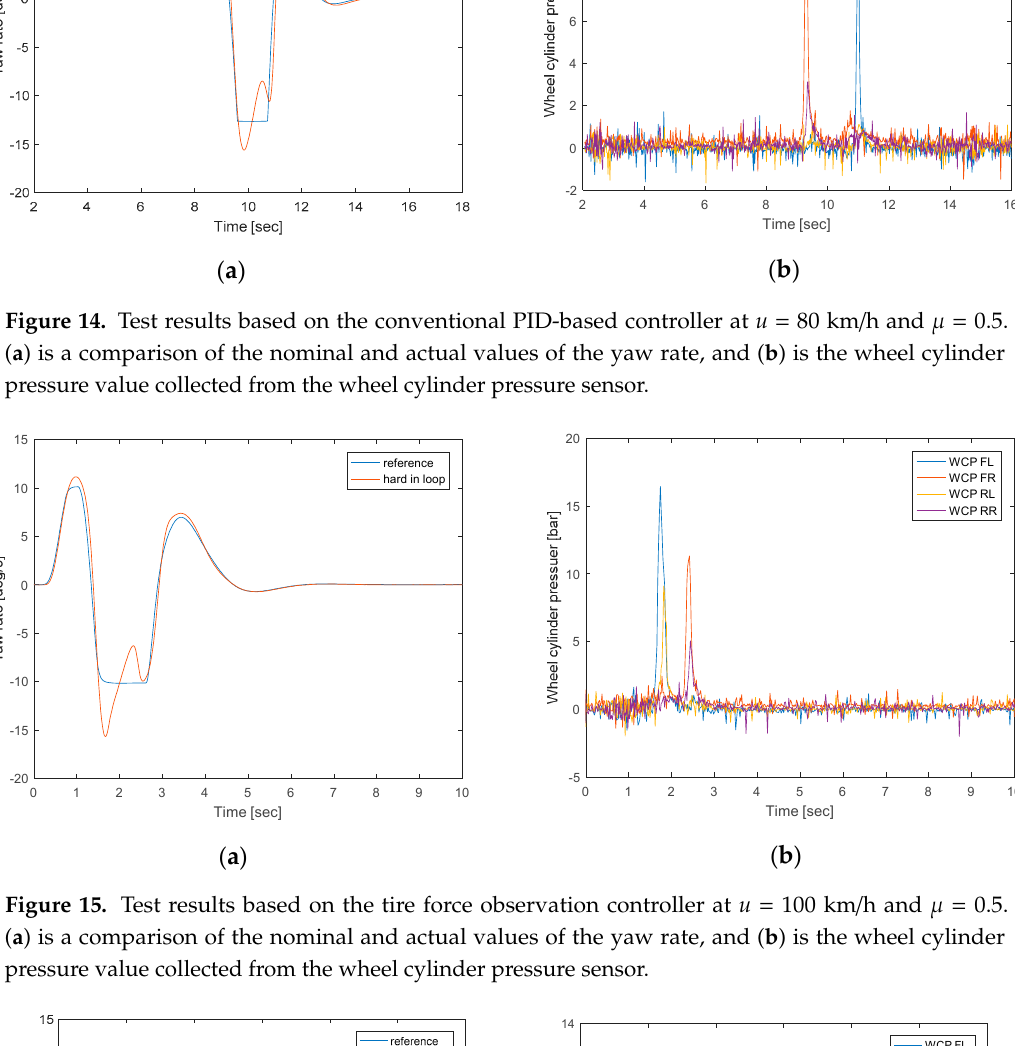
Figure 15. Test results based on the tire force observation controller at u = 100 km / h and µ = 0.5. ( a ) is a comparison of the nominal and actual values of the yaw rate, and ( b ) is the wheel cylinder pressure value collected from the wheel cylinder pressure sensor.